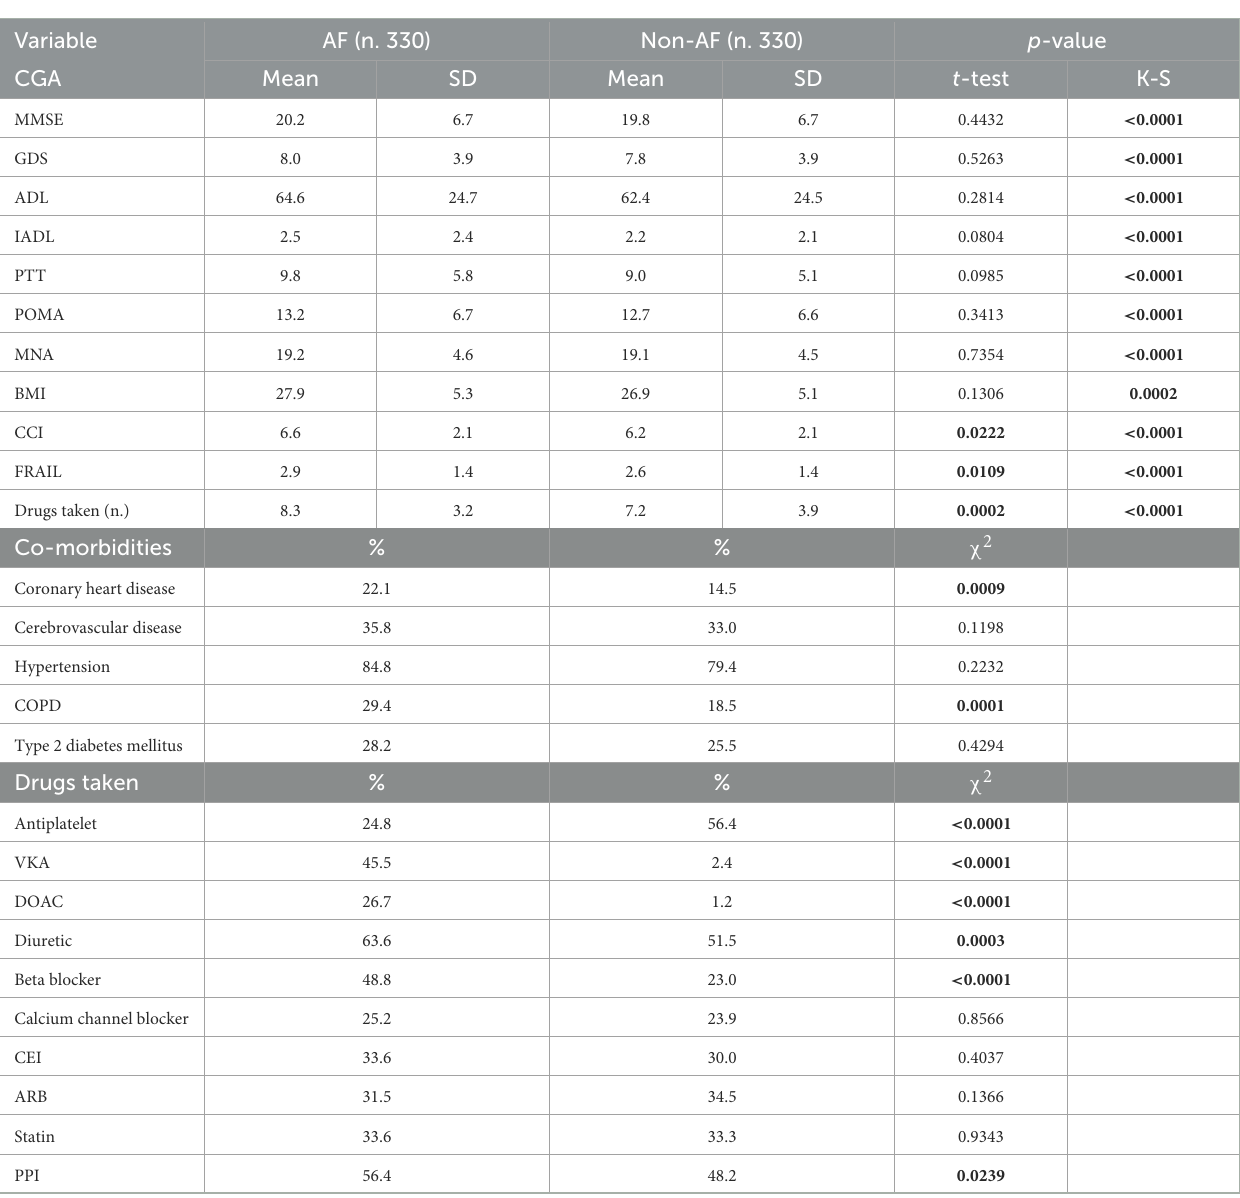
TABLE 1 Characteristics of AF and non-AF